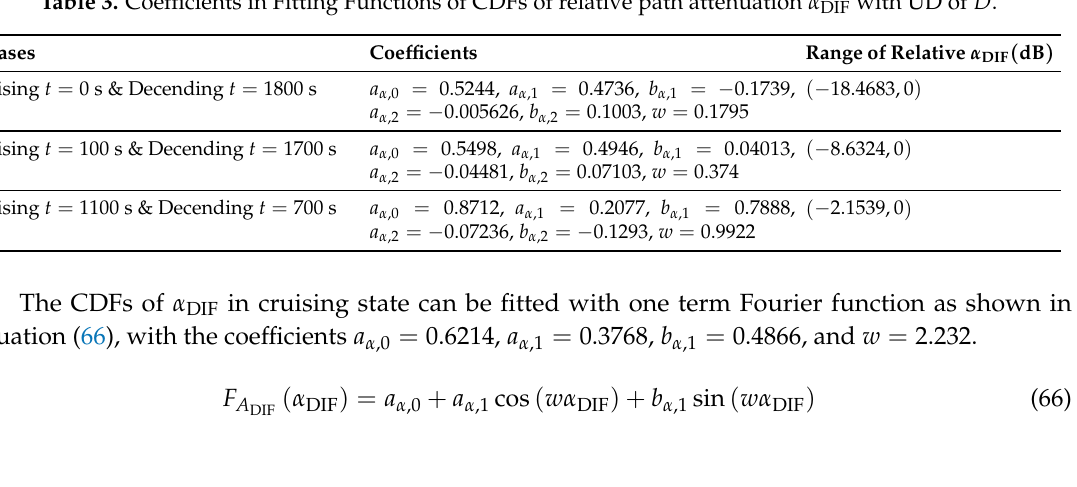
Table 3. Coefficients in Fitting Functions of CDFs of relative path attenuation α DIF with UD of D